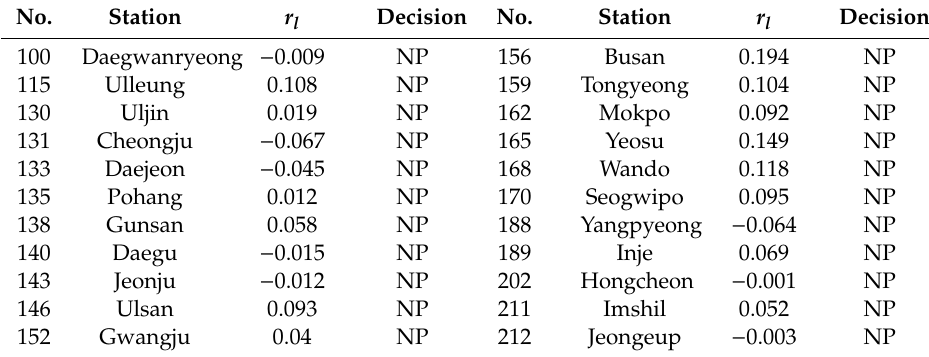
Table 6. Analysis of the coe ffi cient using climate change scenarios.